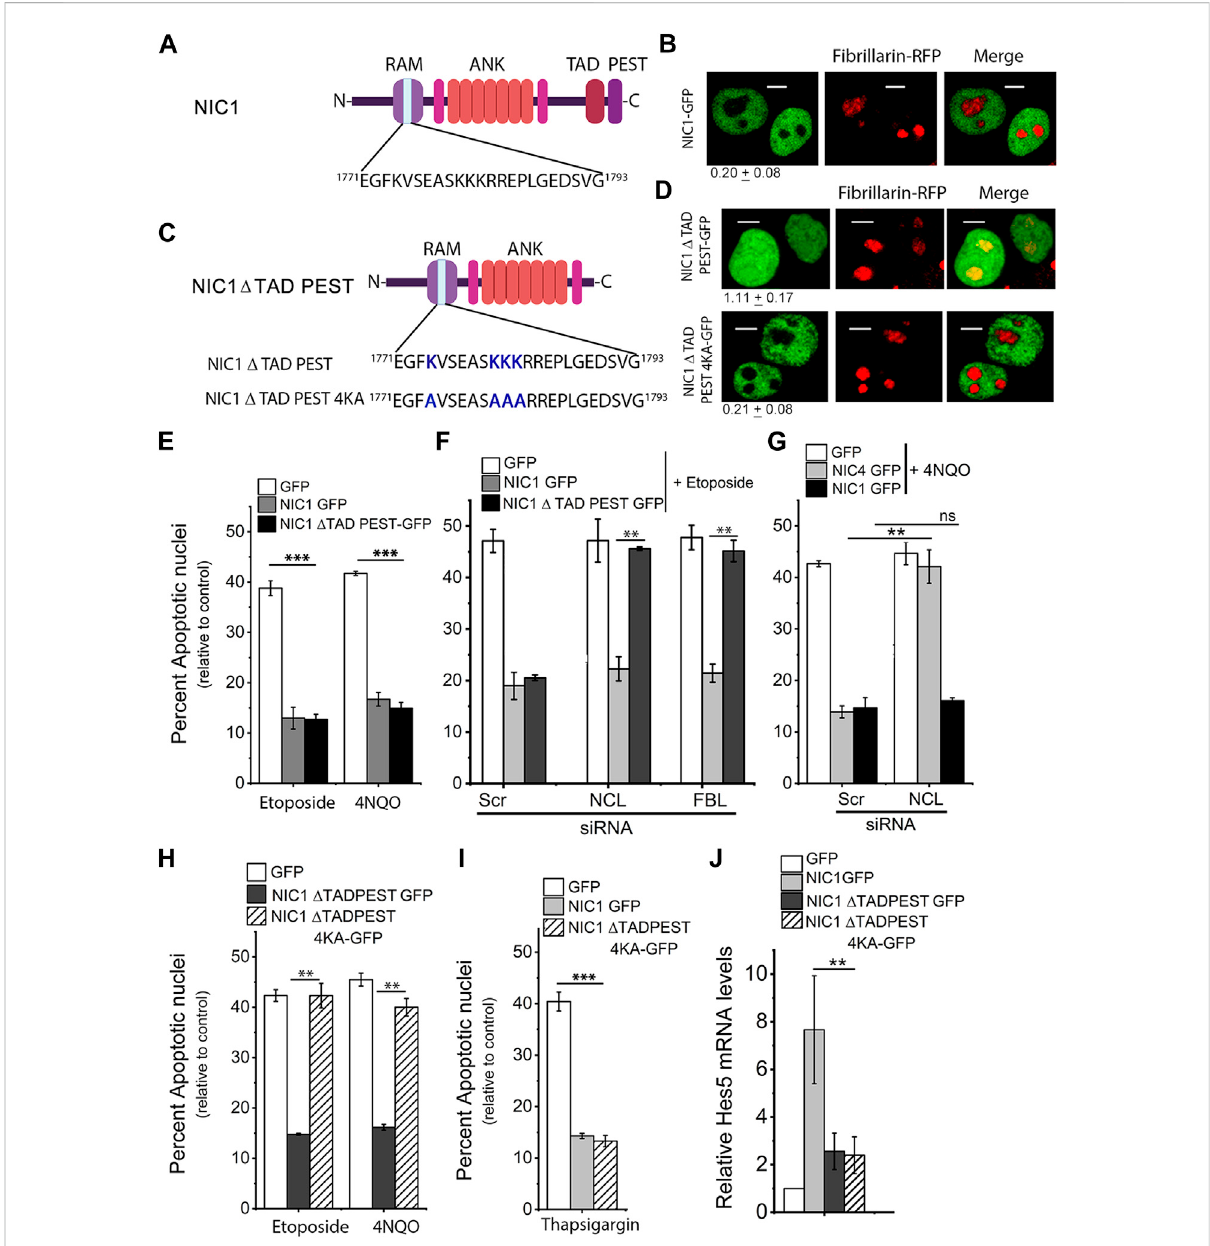
FIGURE 1 Deletion of TADPEST domains allows nucleolar localization of the Notch1 intracellular domain (NIC1). (A) Schematic showing the putative Nucleolar LocalizationSequence(NoLS)inNIC1. (B) RepresentativeconfocalimagesofHEKcellsco-expressingNIC1-GFPandFibrillarin(FBL)-RFPimaged24 hpost- transfection. Images are representativeof 70 cellsacrossthree independent experiments. Scale bar: 5 μ m. 0.20 ± 0.08 shows therelative NIC1 levels inthe nucleolus as compared to the nucleoplasm calculated as described in the methods. (C) Schematic to show the deletion of TAD and PEST domains in NIC1andlysine(K)toalanine(A)mutationintheputativeNoLSinNIC1- Δ TADPEST-GFP. (D) RepresentativeconfocalimagesofHEKcellsco-transfectedwith NIC1- Δ TADPEST-GFP or NIC1- Δ TADPEST 4KA-GFP and Fibrillarin-RFP plasmids and cultured for 24 h in complete medium before imaging. Images are representativeofatleast30cellsacrosstwoindependentexperiments.Scalebar:5 μ m.1.11±0.17(NIC1 Δ TADPEST)and0.21±0.08(NIC1- Δ TADPEST4KA) show the relative NIC1 levels in the nucleolus as compared to the nucleoplasm. (E) Percent apoptotic nuclei in HEK cells expressing NIC1- Δ TADPEST-GFP, NIC1-GFP,orGFPculturedwithetoposide(10 µM)or4NQO(10 µM)for48 hinmediumcontaining2%FBSandassessedforapoptoticdamageasdescribed in methods. (F) Percent apoptotic nuclei in HEK cells expressing NIC1- Δ TADPEST-GFP, NIC1-GFP, or GFP cultured with etoposide (10 µM) for 48 h in medium containing 2% FBS. HEK cells pre-treated with siRNA to Nucleolin (NCL), FBL, or scrambled control for 48 h were transfected with indicated plasmids,andculturedfor24 hinthecompletemedium,beforeetoposidetreatment. (G) PercentapoptoticnucleiinHEKcellsexpressingNIC1-GFP,NIC4- GFP,orGFPculturedwith4NQO(10 µM)for48 hinmediumcontaining2%FBS.HEKcellspre-treatedwithsiRNAtoNCLorscrambledcontrolfor48 hwere transfected with indicated plasmids, and cultured for 24 h in the complete medium, before 4NQO treatment. (H) Percent apoptotic nuclei in HEK cells expressingNIC1- Δ TADPEST-GFP, NIC1- Δ TADPEST4KA-GFPor GFPculturedwithetoposide(10 µM)or 4NQO(10 µM)for48 hinmediumcontaining 2% FBS. (I) PercentapoptoticnucleiinHEKcellsexpressingNIC1- Δ TADPEST-GFP,NIC1-GFP,orGFPculturedwithThapsigargin(10 µM)for24 hinserum-free medium. (J) Relative Hes5 mRNA levels in HEK cells transfected with NIC1-GFP, NIC1- Δ TADPEST-GFP, NIC1- Δ TADPEST 4KA-GFP or GFP and cultured in complete medium for 30 h. Data plotted as mean ± S.D. of three independent experiments. *** and ** show signi fi cant difference with p -value ≤ 0.001 and ≤ 0.01, respectively, and ns shows non-signi fi cant difference examined using the unpaired student ’ s t-test.